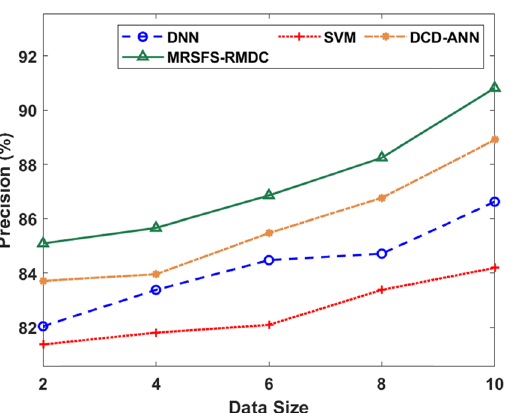
Figure 5: Precision analysis of MRSFS - RMDC model with distinct data size.